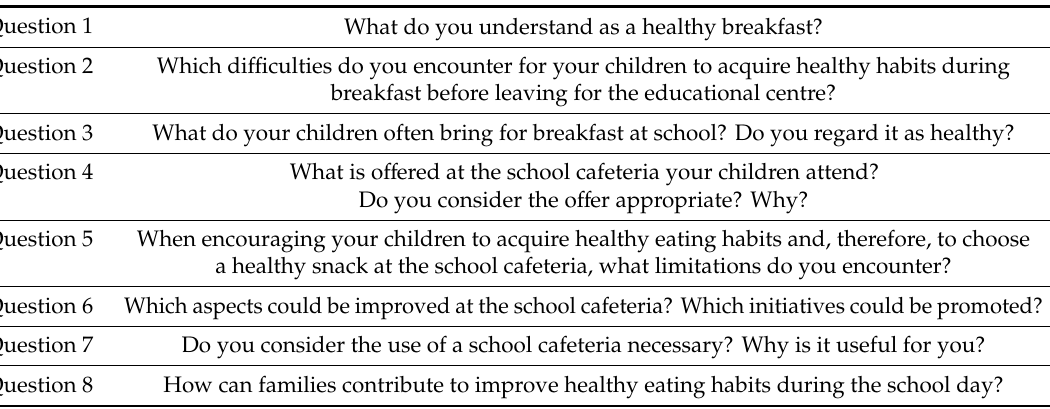
Table 2. Focal group questions script.